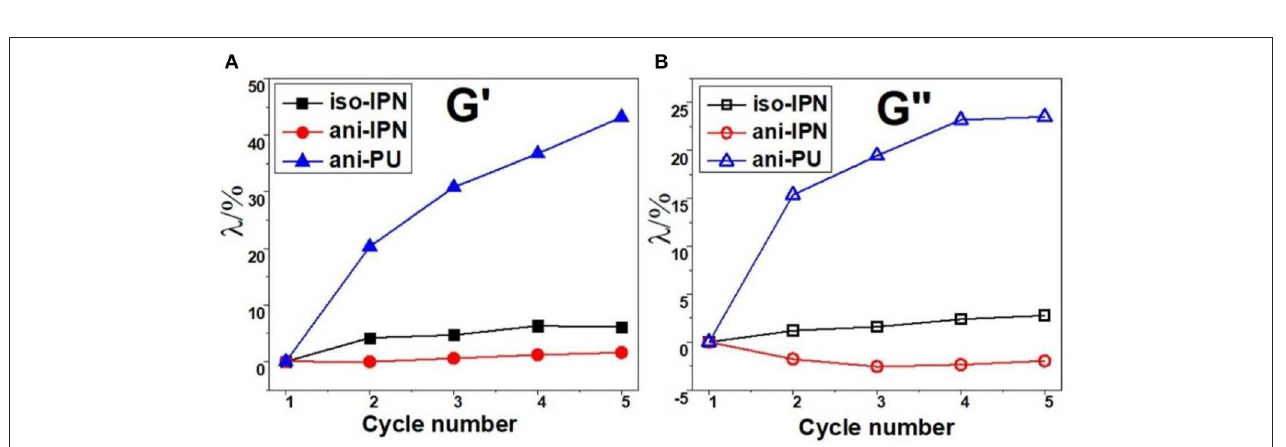
FIGURE 5 | Dependence of the parameter λ ( A : storage modulus; B : loss modulus) on cycle number for the samples under the triangular magnetic field.